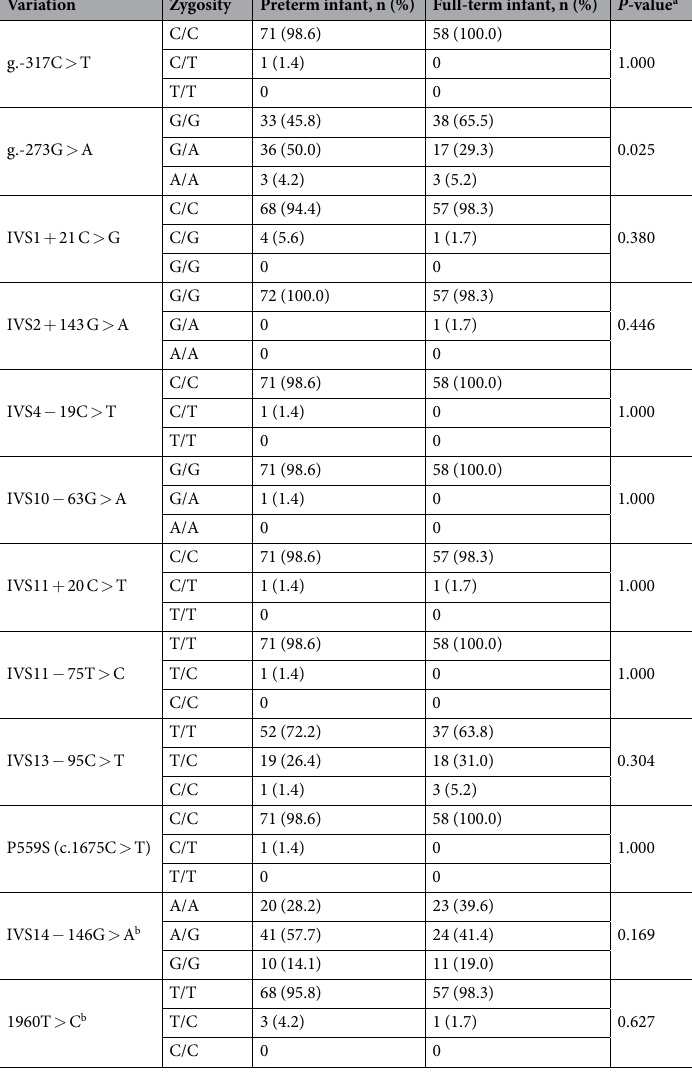
(Supplementary Table S2). In our study population, the minor allele frequency of g.-273G > A was high; in par- ticular, it was higher in the preterm infants (0.292) than in the full-term infants (0.198). In addition, we found that two transcription factors, NF- κ B and GABP α , are involved in the transcriptional regulation of SHP-2 by the two above-mentioned variations. Preterm birth and its associated complications such as brain injury have been known to be caused by multiple pathogenic factors. Maternal or fetal infection and inflammation can induce the release of cytokines such as IL-1, IL-8, IL-10, and TNF, chemokines, and platelet-activating factors 27 . These responses can induce preterm labor 3, 4 and increase ROS production, resulting in the injury of immature oligodendrocytes 5 . The deficient antioxidant capacity of preterm infants further aggravates the insult caused by ROS. Apoptosis of immature oligodendrocytes by ROS is the main pathology of brain injury in preterm infants 5 . While other protein tyrosine phosphatases are widely accepted as negative regulators of signaling events, SHP -2 can act as either a positive or a negative regulator in signaling cascades in a cell type-specific and stimulant-specific manner 28 . SHP-2 is one of the rare protein tyrosine phosphatases that display dual function in signal transduction, showing both a neuroprotective effect and a proapoptotic effect by promoting caspase activa- tion 15, 16, 19 . Since previous studies have reported that SHP-2 plays key roles in various cellular processes including proliferation, survival, differentiation, and metabolism 26 and because SHP-2 is known to be highly expressed in specific brain regions including the cortex, cerebellum, and hippocampus 13 , we compared brain diffusion tensor image (DTI) data in the preterm infants according to the SHP-2 promoter variation, g.-273G > A, and found that myelination of the corpus callosum, PLIC, and optic radiation was significantly delayed in the variant group than in the control group. TBSS is an observer-independent tool used for analyzing DTI data 29 . Using TBSS, brain